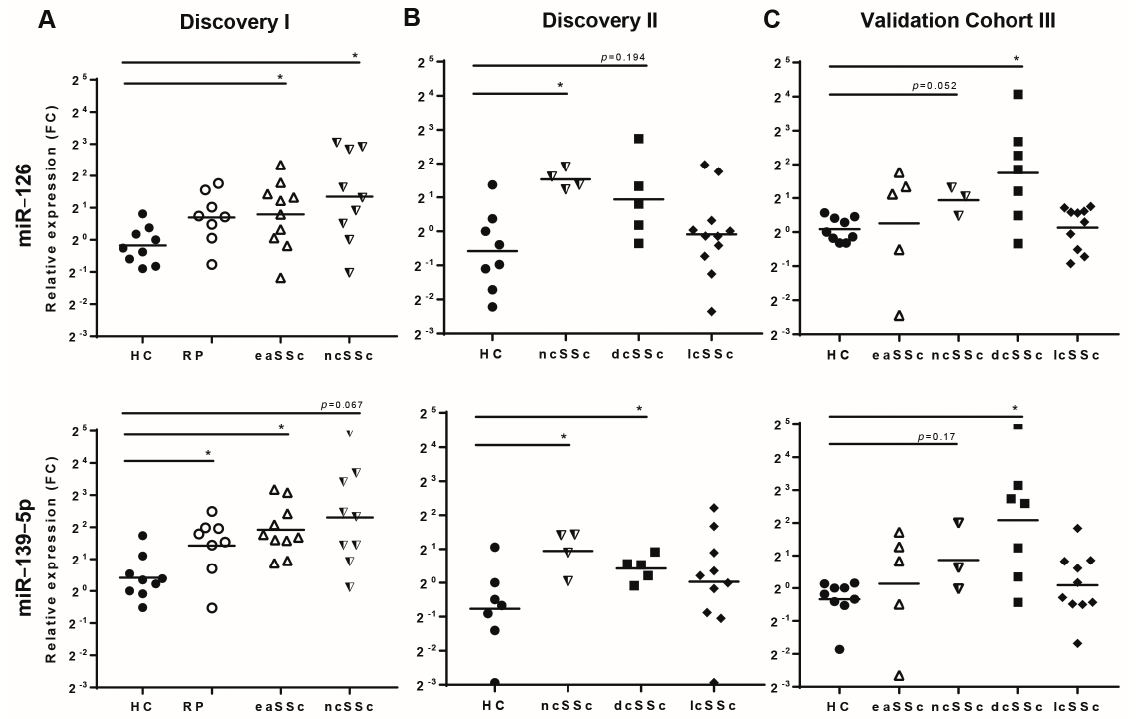
Figure 3. MiR-126 and miR-139-5p are upregulated in SSc patients. The expression of miR-126 and miR-139-5p were analyzed by using the OpenArray platform in the discovery cohort I (HC = 9, RP = 8, eaSSc = 10, ncSSc = 9) ( A ) and II (HC = 8 ncSSc = 4, dcSSc = 5, lcSSc = 11) ( B ) and in the validation cohort (HC = 9, eaSSc = 5, ncSSc = 3, dcSSc = 7, lcSSc = 10) ( C ). The three independent cohorts were screened for data validation, and no technical replicates were used. Data were normalized using ExpressionSuite and ThermoFisher cloud software (independent t-test, uncorrected p -value < 0.05). The expression of each miRNA was calculated as Fold Change (FC) as compared to the healthy control group. Data presented as geometric mean (mid-line). HC, healthy controls; eaSSc, early SSc; ncSSc, non-cutaneous SSc; dcSSc, diffuse cutaneous SSc; lcSSc, limited cutaneous SSc, * indicates p -value <